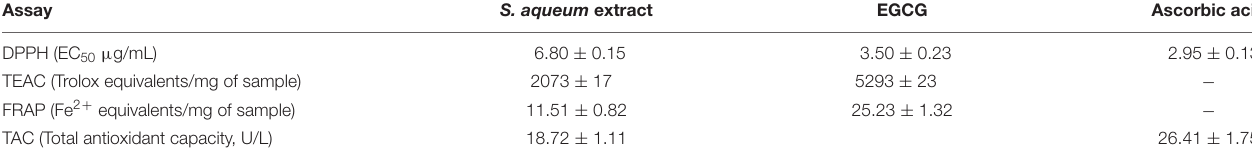
TABLE 2 | Antioxidant properties of the extract as compared to positive controls EGCG and vitamin C. Assay